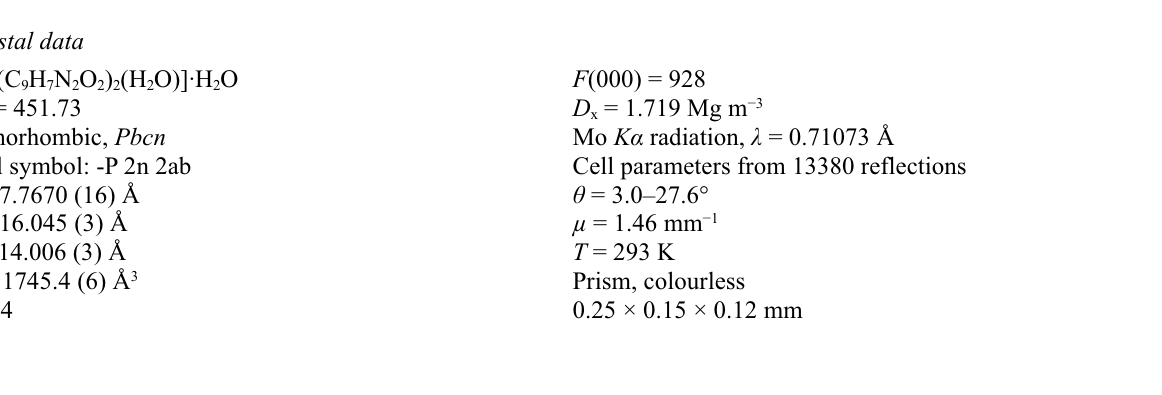
Crystal packing of the compound (I). Hydrogen bonds are shown as dashed lines. Aquabis(2-methyl-4-oxopyrido[1,2- a ]pyrimidin-9-olato)zinc(II)